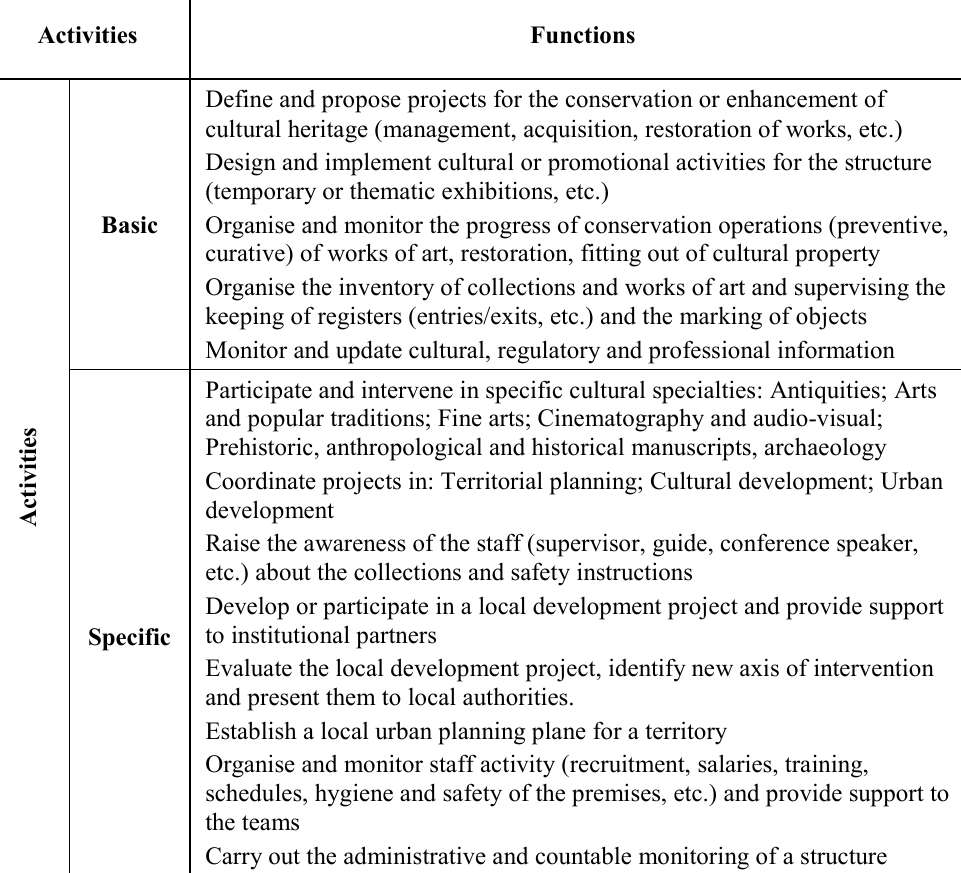
Table 3. Activity Framework of Urban Planner Trade on the